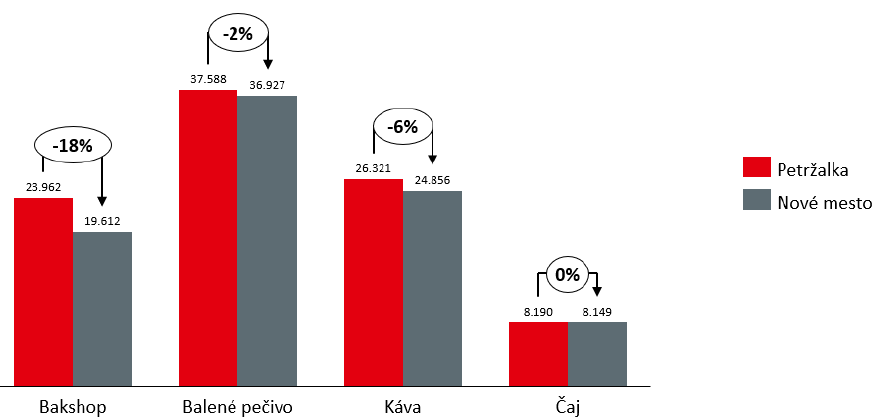
Figure 13. Turnover of the branches of Petržalka and Nové Mesto nad Váhom in selected parts of